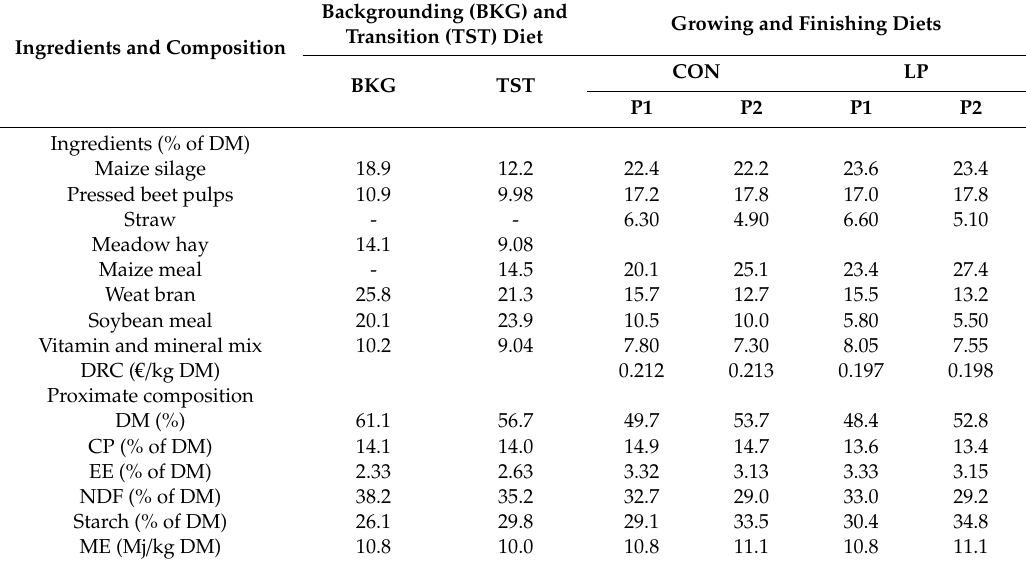
Table 1. Ingredients, proximate composition and daily cost of the ration (DRC) of diets (low protein, LP; control, CON) fed to the young Charolais bulls during backgrounding, transition, growing (P1) and finishing (P2) phases at Rovigo Province,